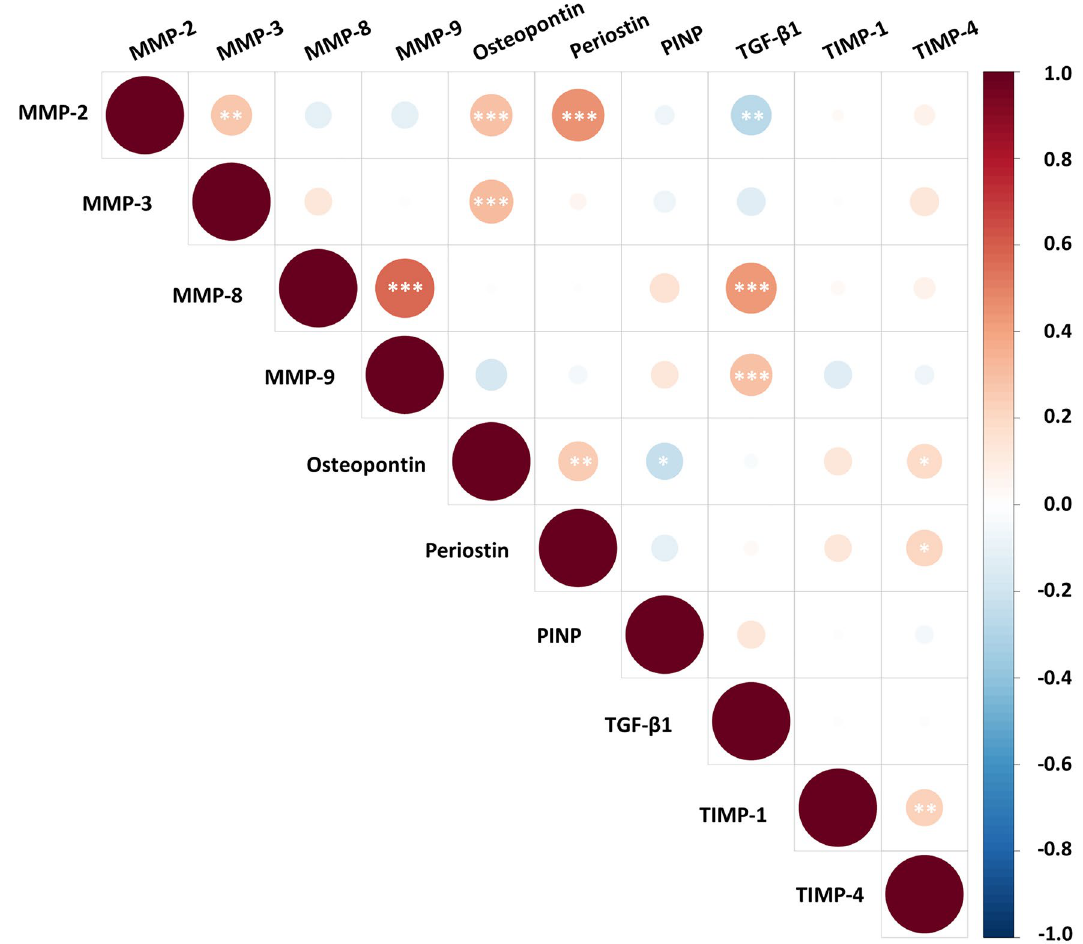
Figure 1. Correlation matrix between extracellular matrix biomarkers. Spearman’s Rank correlation was performed between extracellular matrix biomarker pairs. Red shading indicates positive correlations and blue shading indicates inverse correlations. Significance is shown by white asterisk symbols. * p < 0.05, ** p < 0.001, *** p < 0.0001. This image was created using the corrplot package in R version 4.0.2, www.R- proje ct.